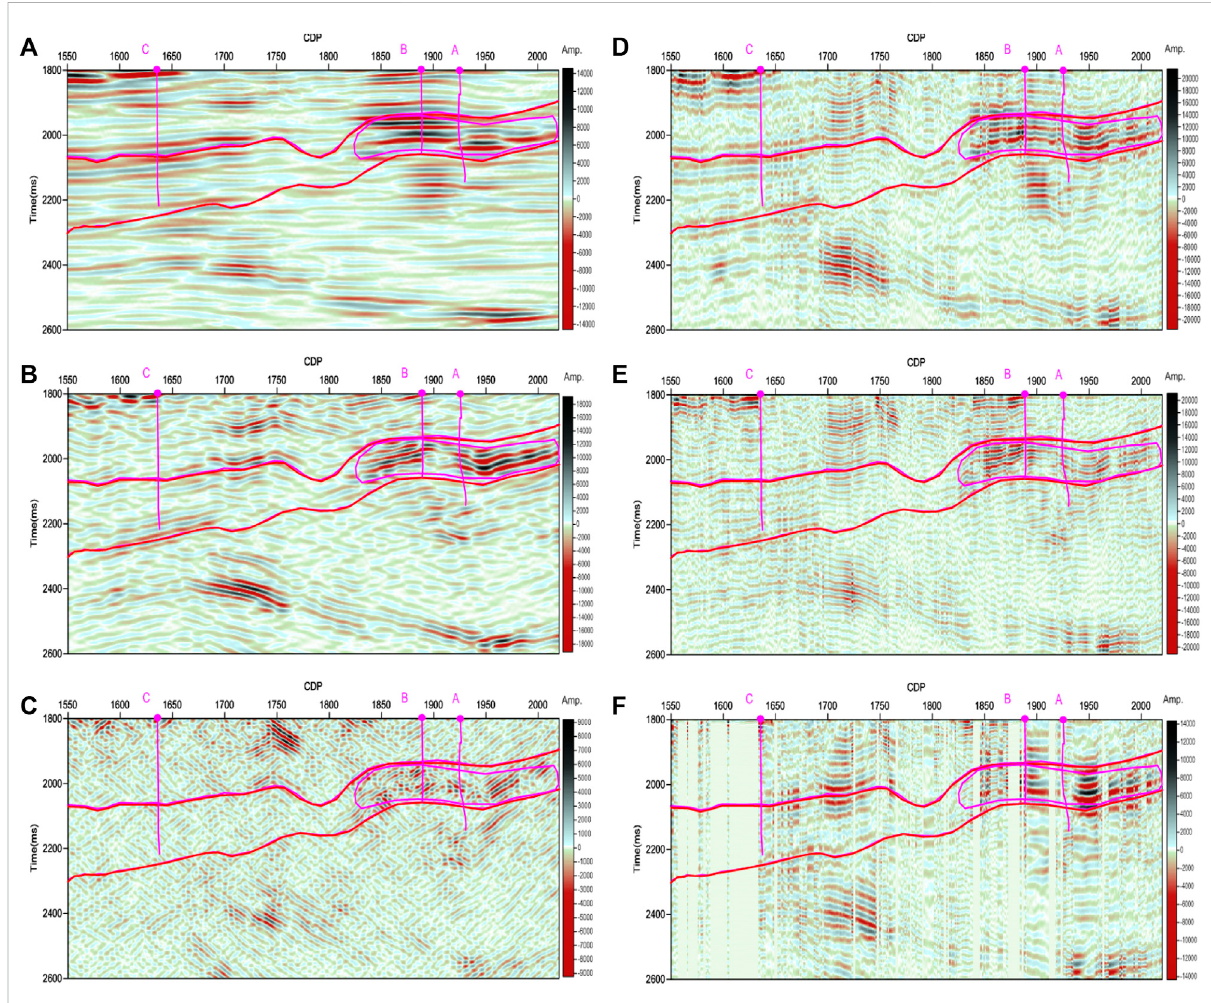
FIGURE 7 MFsoftheseismicsection. (A) IMF1obtainedbyMVMD. (B) IMF2obtainedbyMVMD. (C) IMF3obtainedbyMVMD. (D) IMF1obtainedbyVMD. (E) IMF2 obtained by VMD. (F) IMF3 obtained by VMD.It is of note that for MVMD, the number of data channels is set to 3. The number of theprede fi ned multivariate modulated oscillations for VMD and MVMD is 3. The moderate bandwidth constraint for VMD and MVMD is